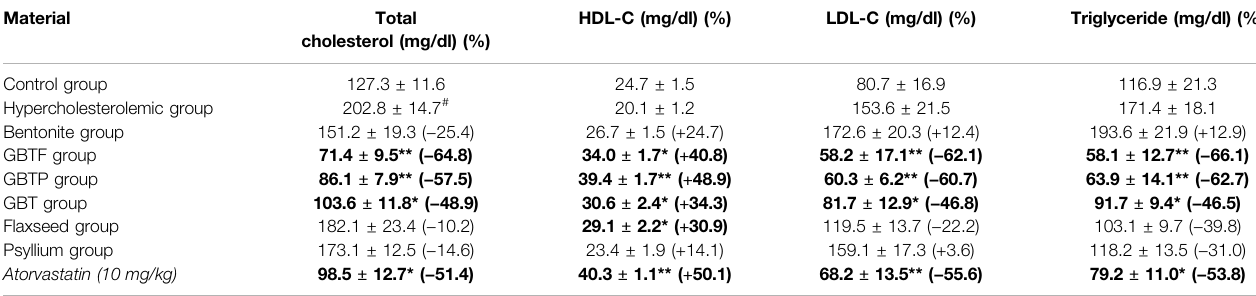
TABLE 3 | Effects of test materials on serum TC, HDL-C, LDL-C, and TG levels. Material